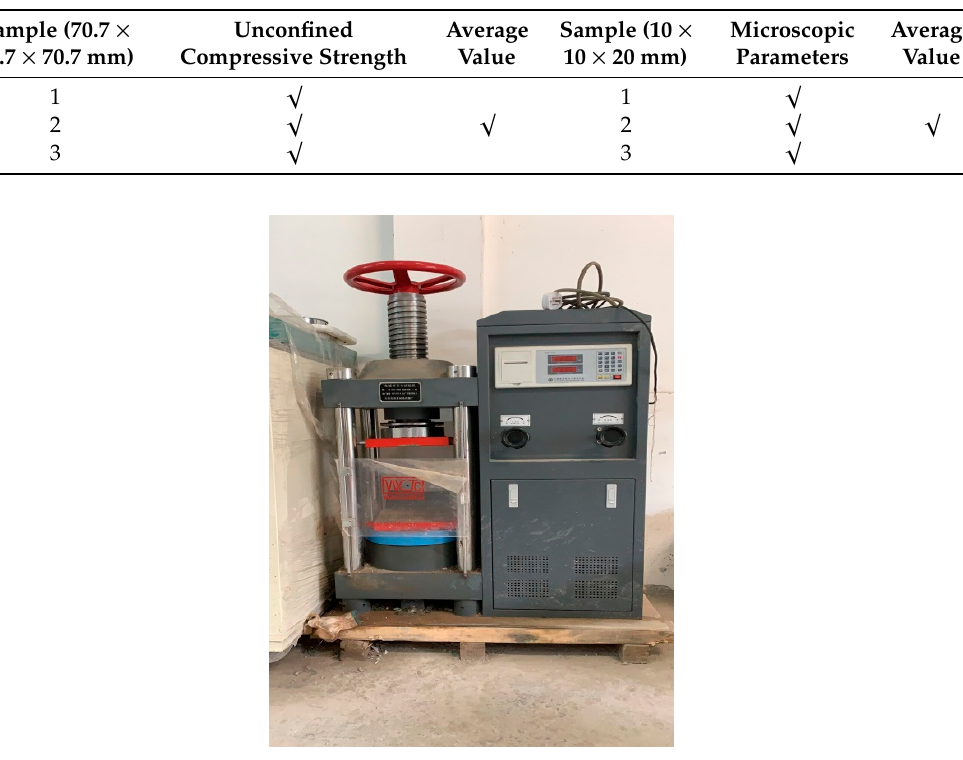
Figure 2. The machine for the unconfined compression test.